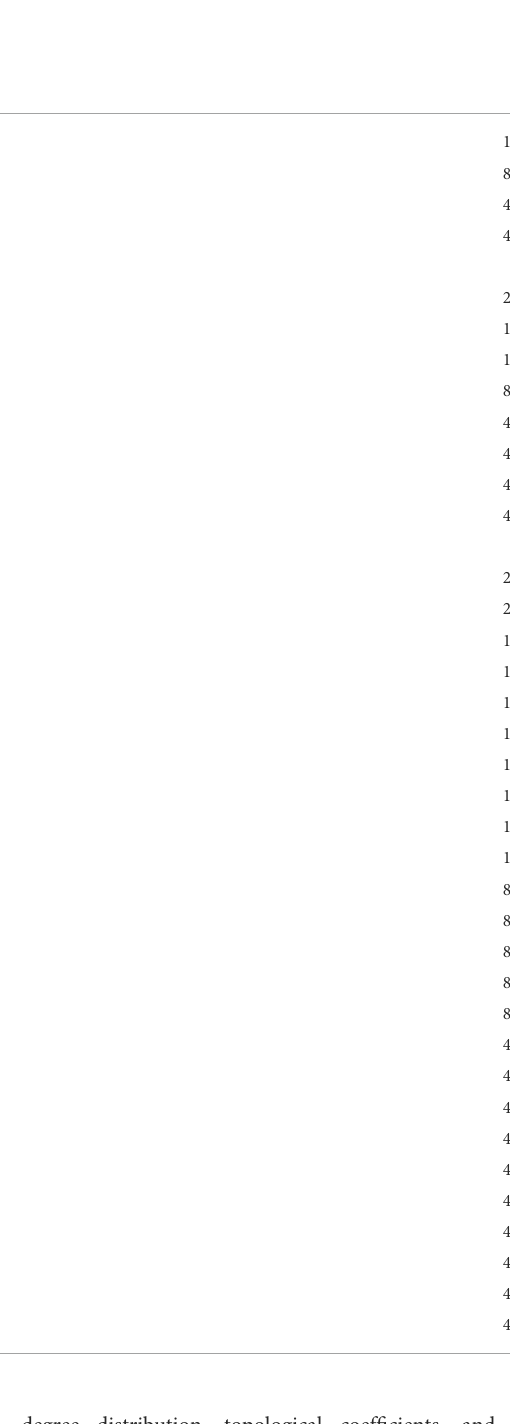
TABLE 1 Temporal enriched